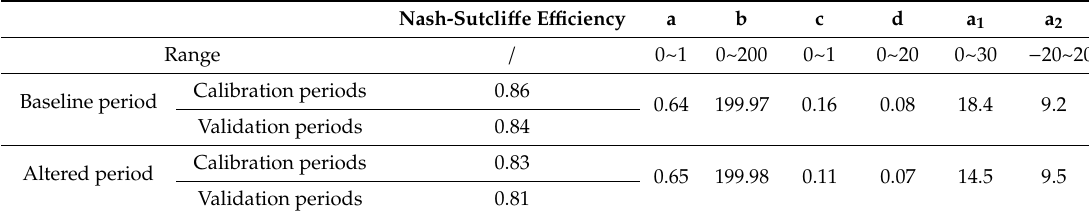
Table 5. NSE values for simulated and calibrated parameter